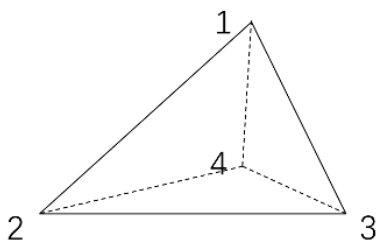
Figure 5. Tetrahedral unit.